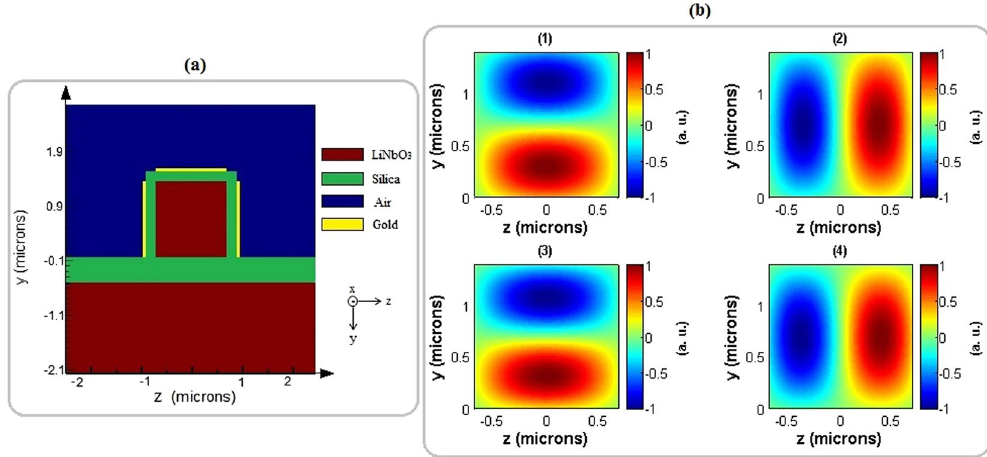
Figure 2. ( a ) Schematic representation of designed modulator. Red: LiNbO 3 , green: silica, yellow: gold electrodes and blue: air; ( b ) Normalized electric field distributions of the guided | TE 01 〉 (1), | TE 10 〉 (2), | TM 01 〉 (3), and | TM 10 〉 (4) modes in the proposed modulator.